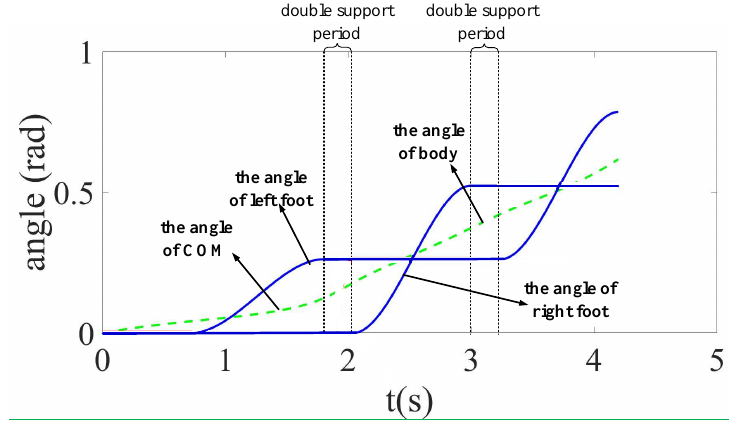
Figure 16. Angle data for gait